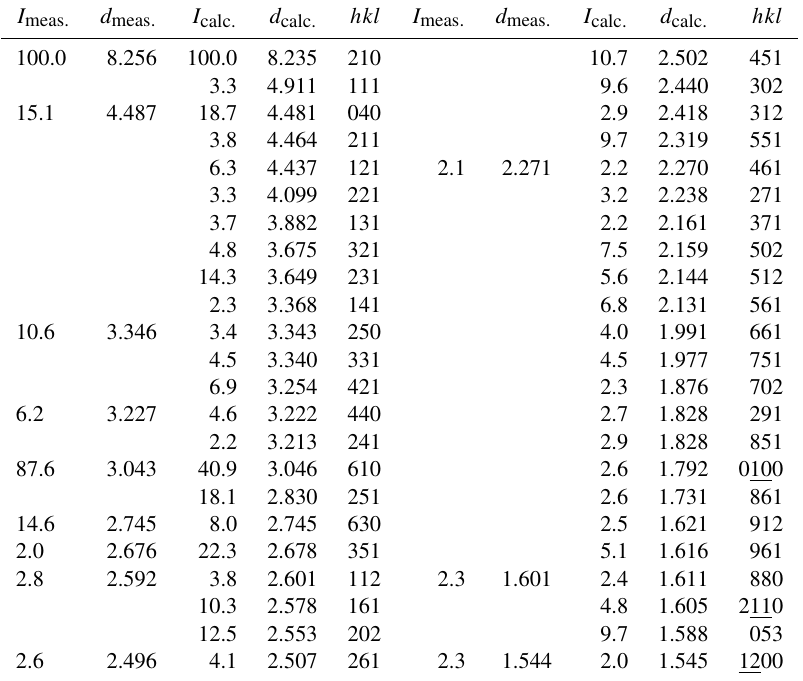
Table 2. Observed X-ray powder diffraction data ( d in Å) and calculated pattern based on X-ray single-crystal refinement of ferro-ferri- holmquistite ∗ . I meas . d meas . I calc . d calc . hkl I meas .